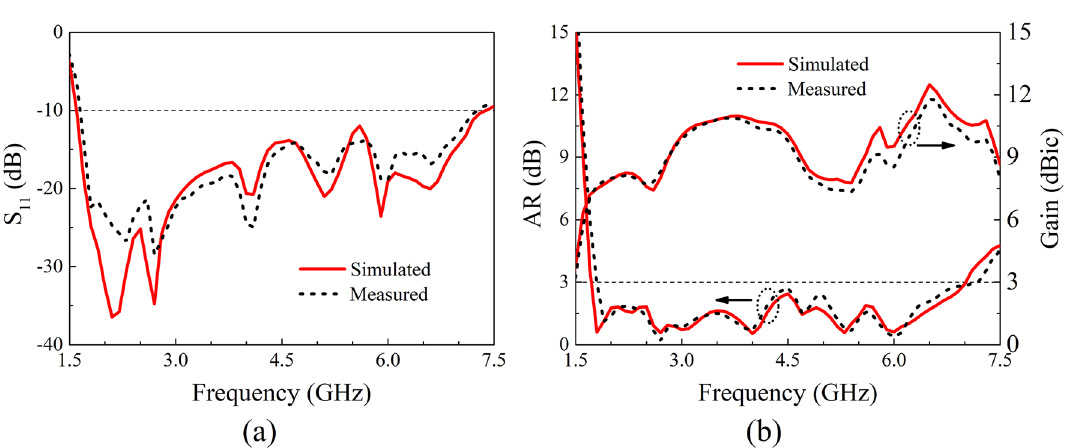
Figure 10. Simulated and measured results of the proposed antenna. ( a ) S 11 , ( b ) AR and